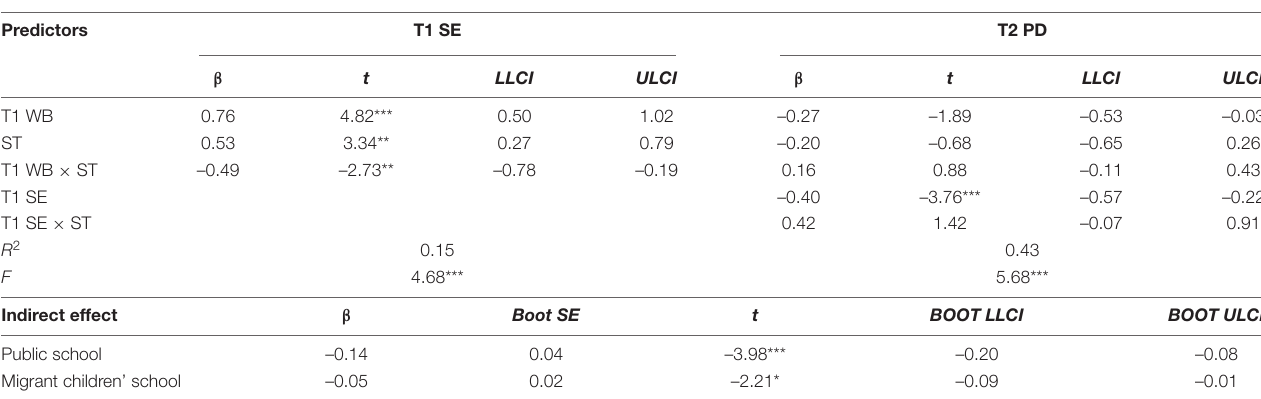
TABLE 3 | Testing the moderated mediation effect of wellbeing (T1) on perceived discrimination (T2).